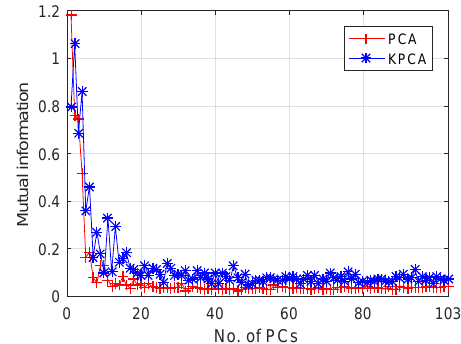
Figure 12. MI between each PC and class label for PCA and KPCA: PCA (red+ line); KPCA (blue*